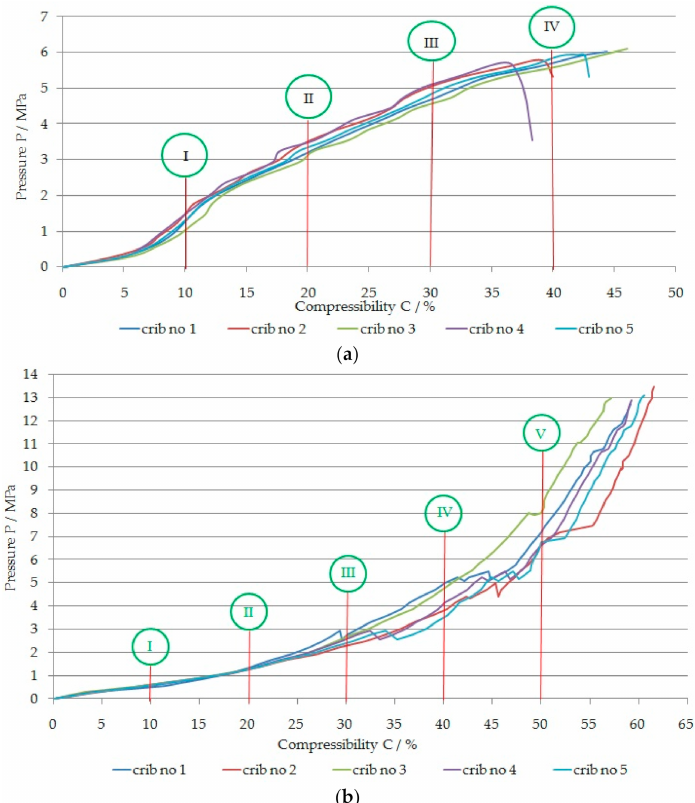
Figure 10. Pressure-compressibility characteristics of wooden crib models filled with gangue: ( a ) Three-point; ( b ) Four-point; I–V—compressibility